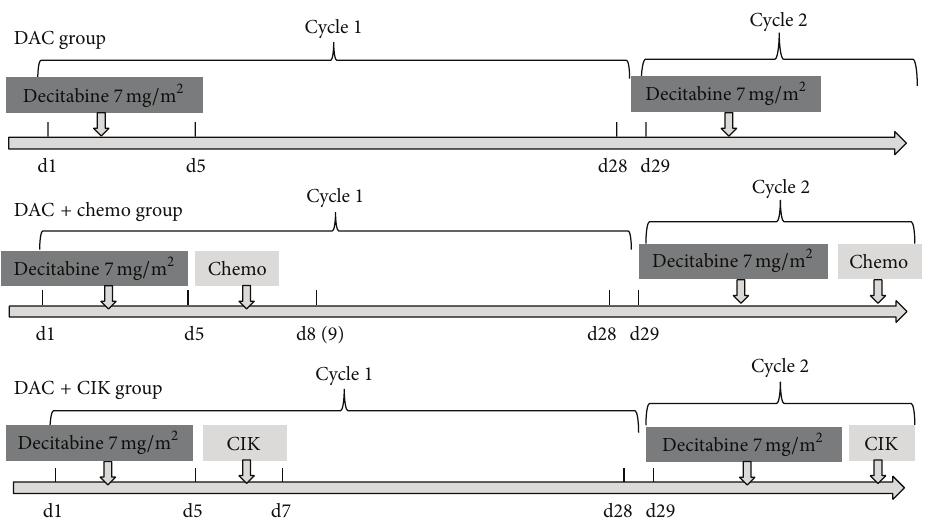
Figure 1: Study design. Chemo: chemotherapy; CIK: cytokine induced killer